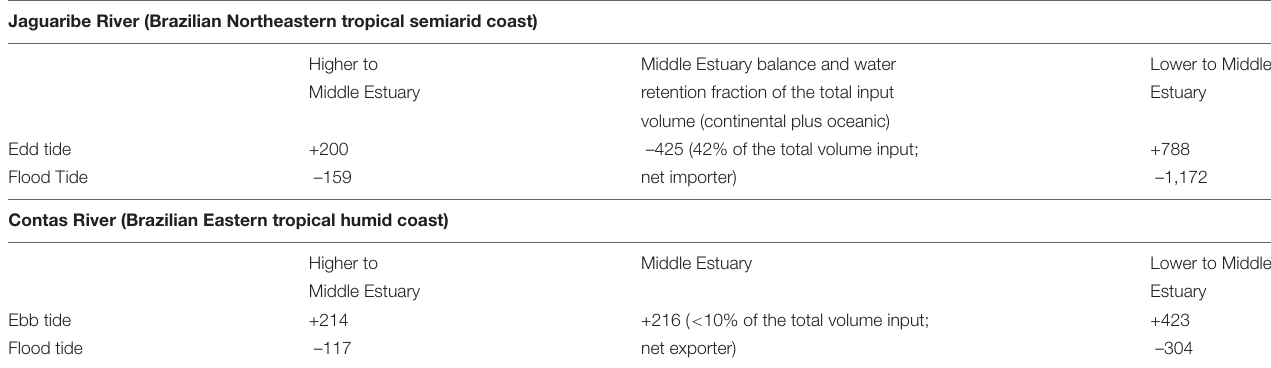
TABLE 1 | Net water balance in the Jaguaribe and Contas Rivers during ebb and flood tides in dry periods from ADP data. Jaguaribe River (Brazilian Northeastern tropical semiarid